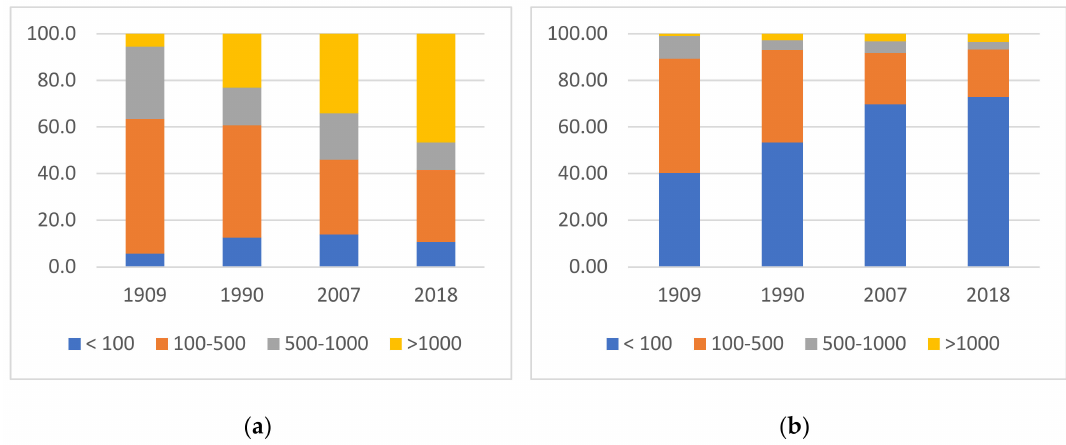
Figure 8. Structural changes in the rural settlement system of the Mogilev district (in relative units): ( a ) population; ( b ) rural settlement